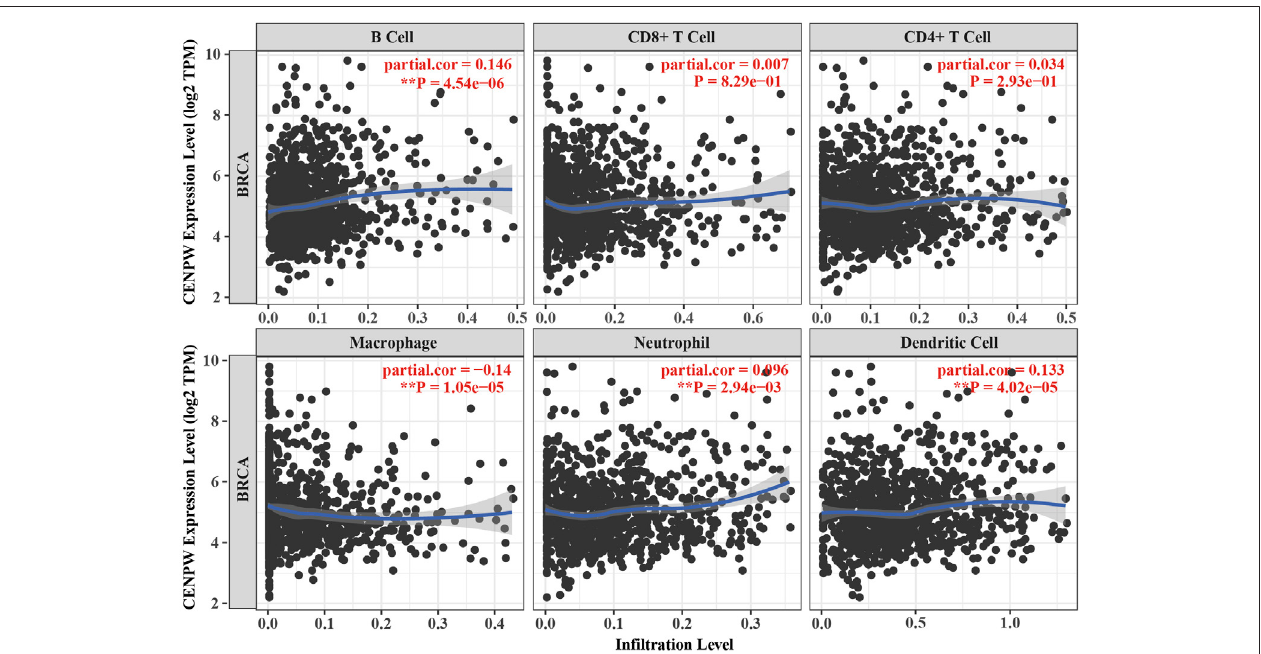
FIGURE 8 | Immune in fi ltration data from the TIMER2.0 database. The relation between CENPW expression and the immune in fi ltration level in BRCA.